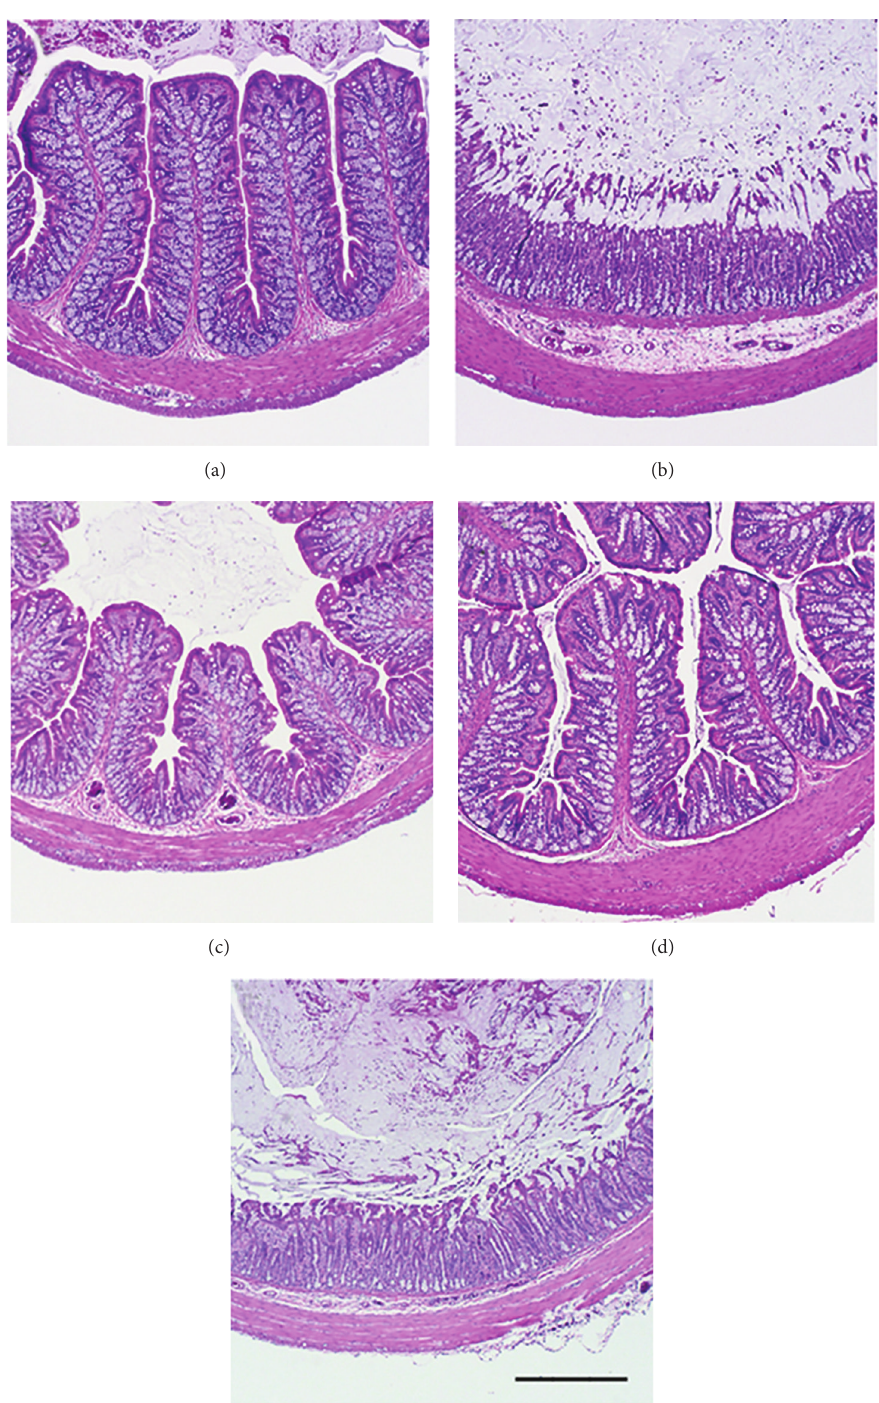
Figure 4: The effects of toxin A on colonic histopathology and protection against these effects by sulfasalazine and 5-ASA but not sulfapyridine. H&E-stained sections of rat colonic segments after they were treated intraluminally for 3h with vehicle (a), 5 𝜇 g of toxin A (b), 5 𝜇 g of toxin A after chronic treatment with 100mg/kg ⋅ day of sulfasalazine for 5 days (c), 5 𝜇 g of toxin A after acute pretreatment with 100 𝜇 g of 5-ASA for 30 minutes (d), and 5 𝜇 g of toxin A after acute pretreatment with 100 𝜇 g of sulfapyridine for 30 minutes (e). Scale bar, 100 𝜇